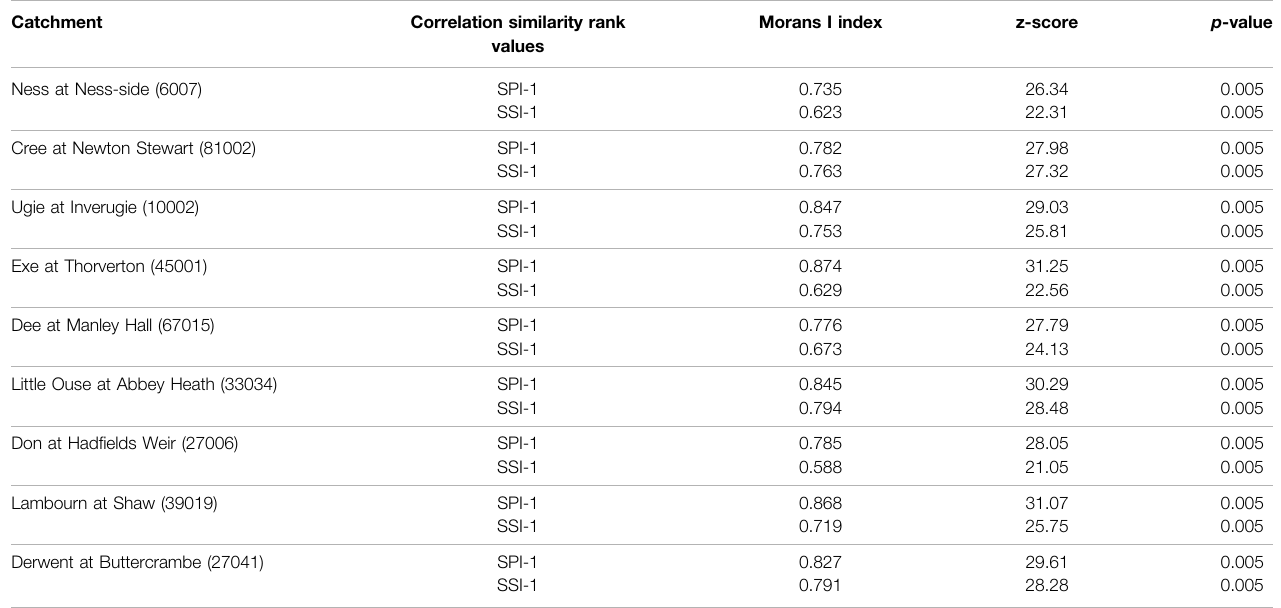
TABLE 2 | Results of the Global Morans I statistical analysis for the similarity rank values mapped in Figures 5 , 6 . Where the z-score is positive and p -value signi fi cant then the similarity rank values are more clustered than would be expected if the underlying spatial processes were random. The Morans I Index indicates the strength of the similarity rank value